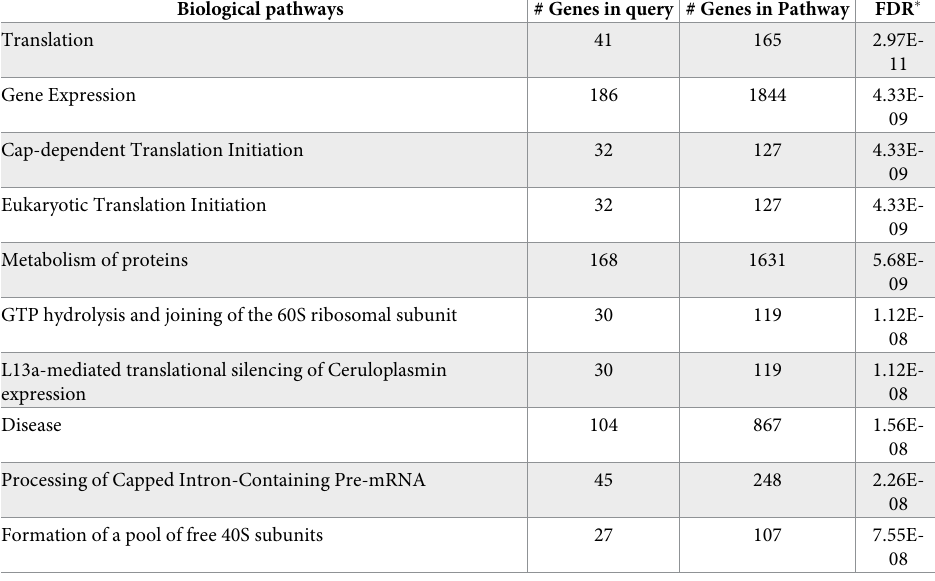
Table 4. Top 10 biological pathways identified by